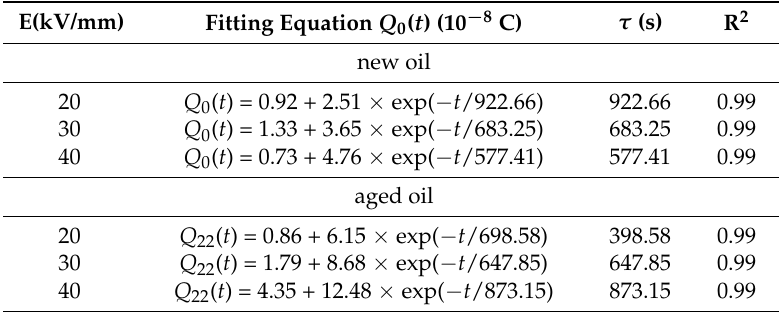
Table 2. The charge detrapping expression based on the first order exponential fitting analysis for oil impregnated insulation paper with new and aged oil.